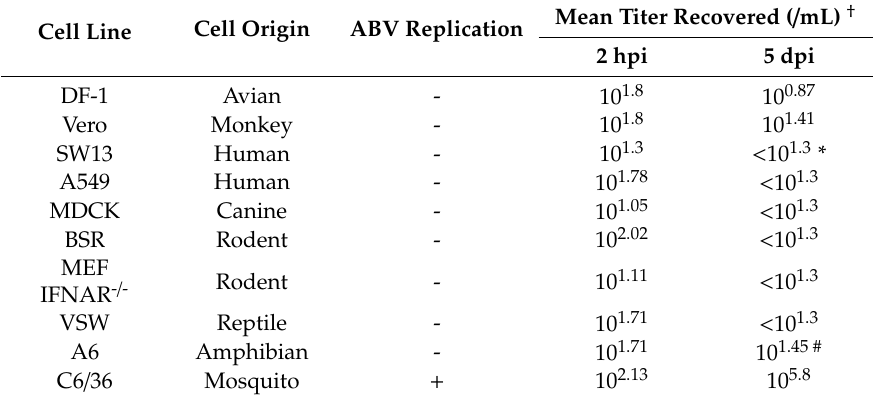
Table 2. Summary of findings for ABV infection of vertebrate